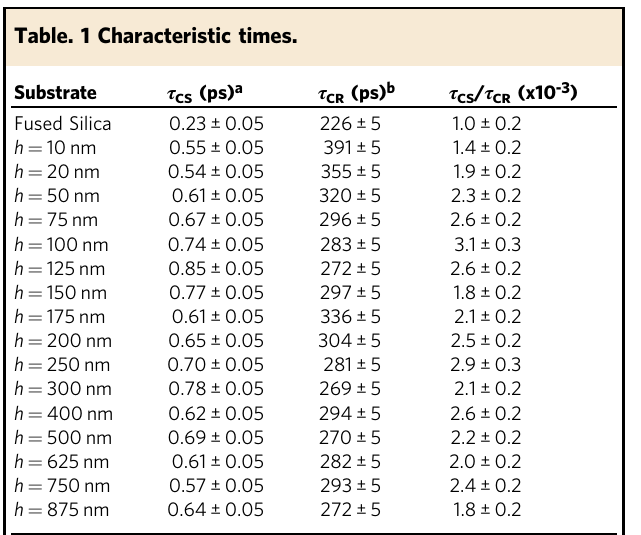
Charge separation ( τ CS ), recombination ( τ CR ), and their ratio ( τ CS / τ CR ) obtained by transmittance mode transient absorption spectroscopy of donor:acceptor thin fi lms on 4 pair substrates of different spacer thickness ( h ). a